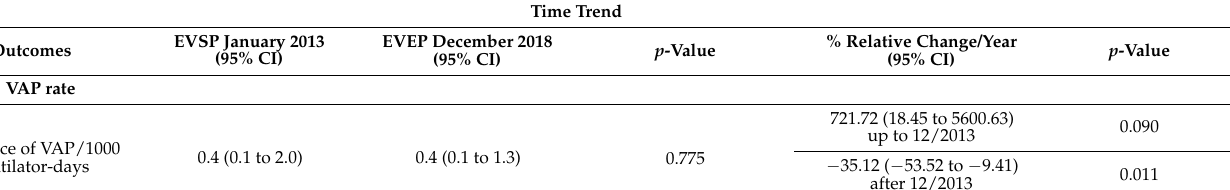
Table 4. Time trend of the incidence rate of VAP and bacteremia in the ICU, January 2013 to